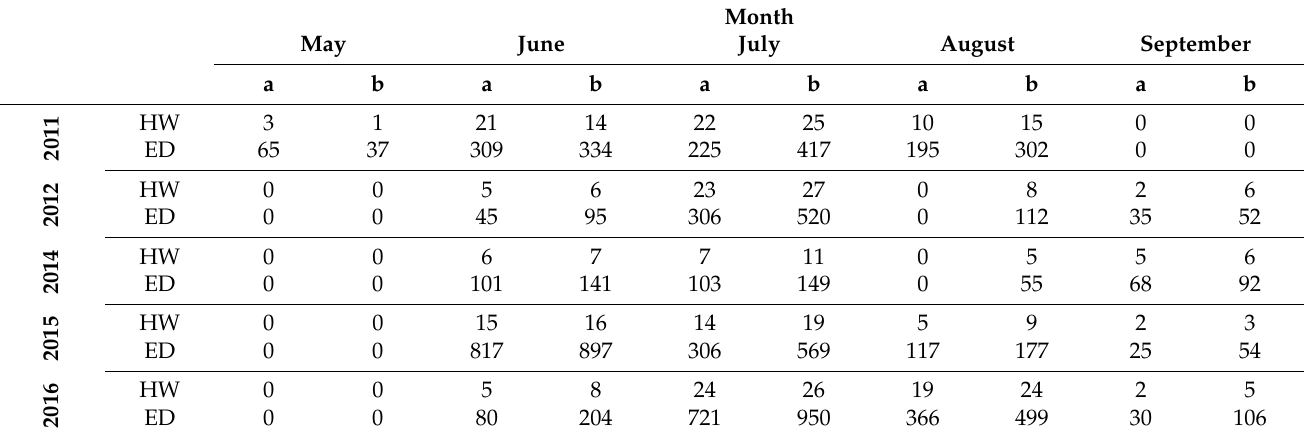
Table 2. Frequency of heat wave days and HRI ED visits in North Carolina physiographic regions.